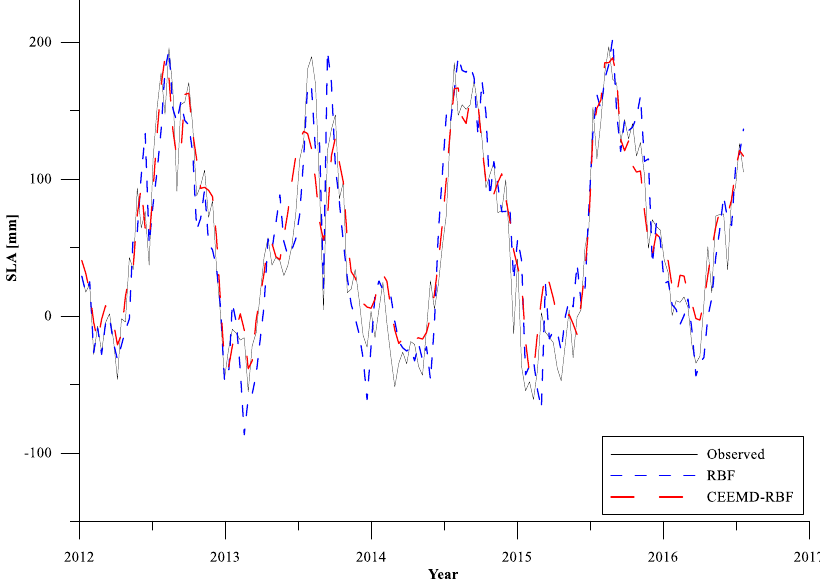
Figure 6. Observed and estimated sea level anomalies derived by the optimal RBF model and CEEMD-RBF combined model during the testing period.